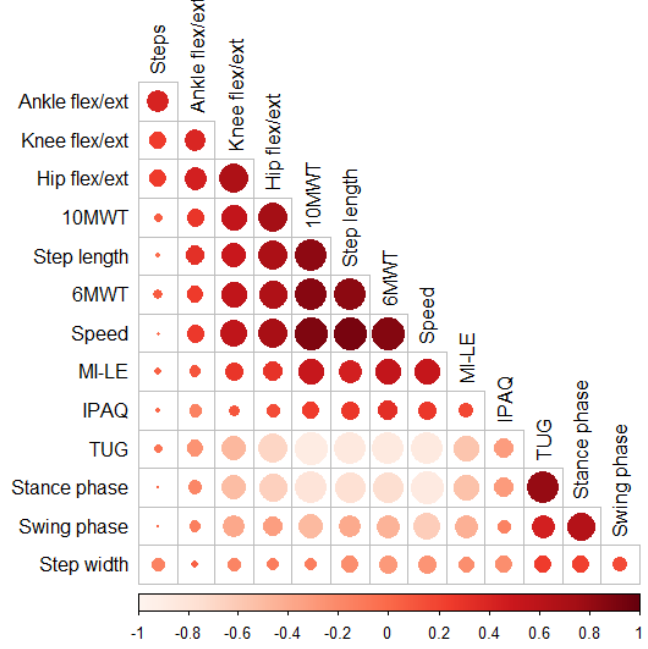
Figure 3. Correlation matrix of clinical and kinematic gait measures